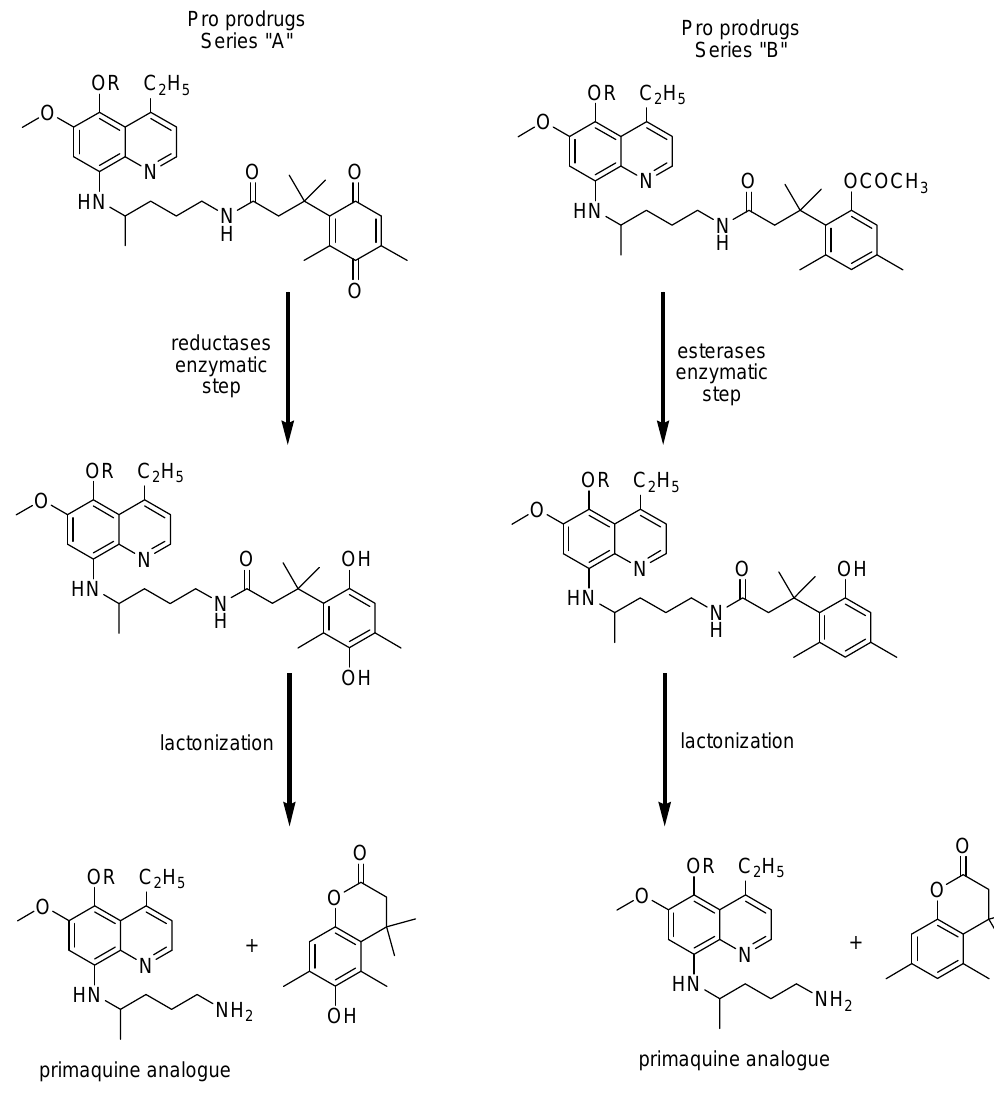
Figure 24. Pro-prodrug series of primaquine analogue (R=C regeneration of parent